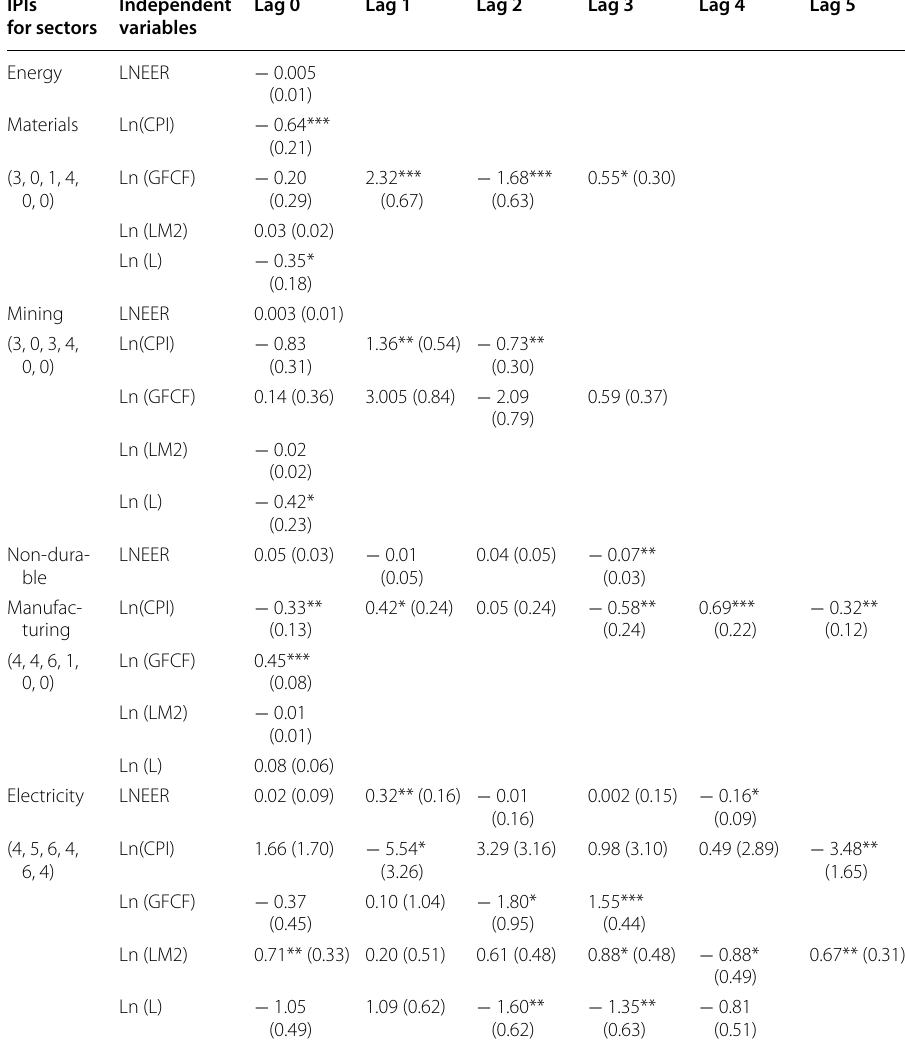
Table 5 Short-run ARDL